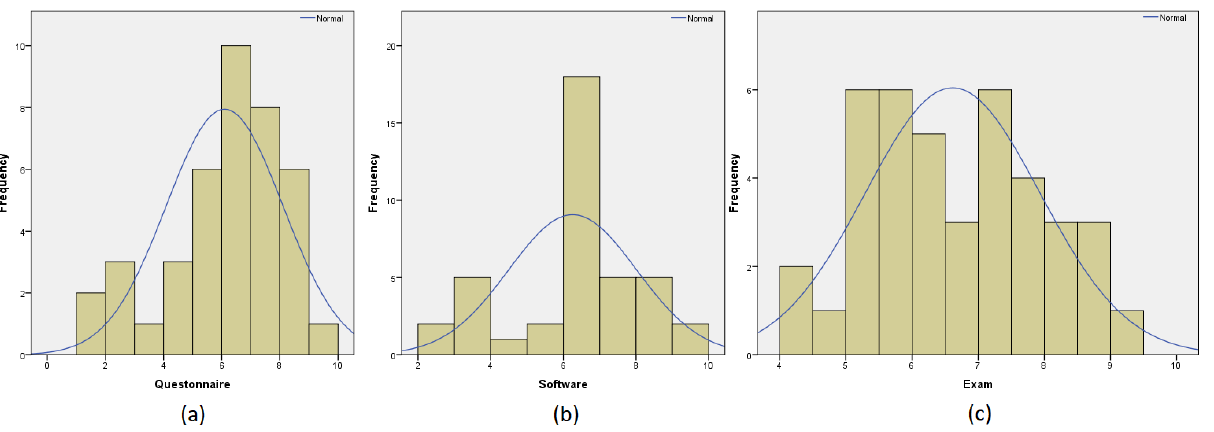
Figure 17. Histogram and normal curve for ( a ) questionnaires, ( b ) software, and ( c ) exams.